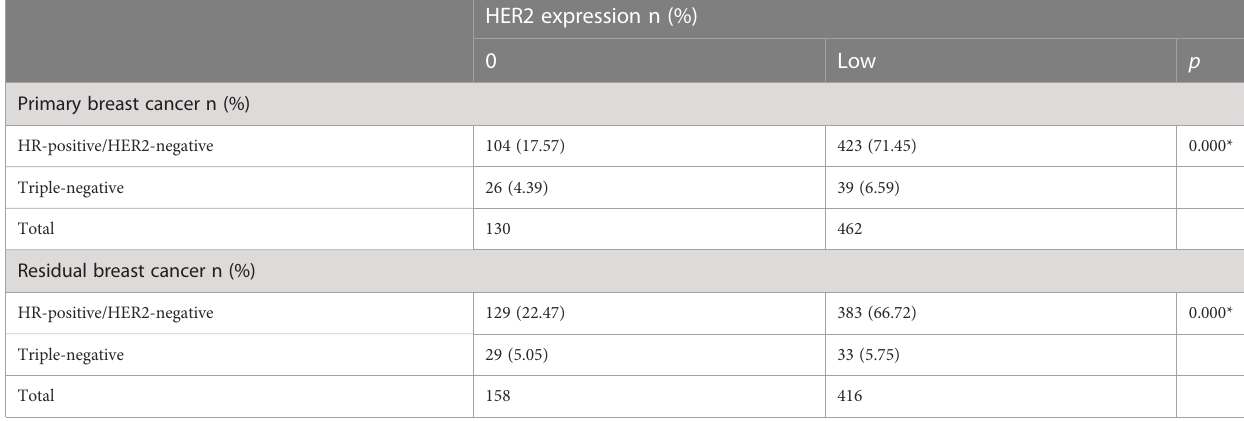
TABLE 2 HER2 expression distribution according to breast cancer subtype in the HER2-negative primary and residual breast cancer cohort. HER2 expression n